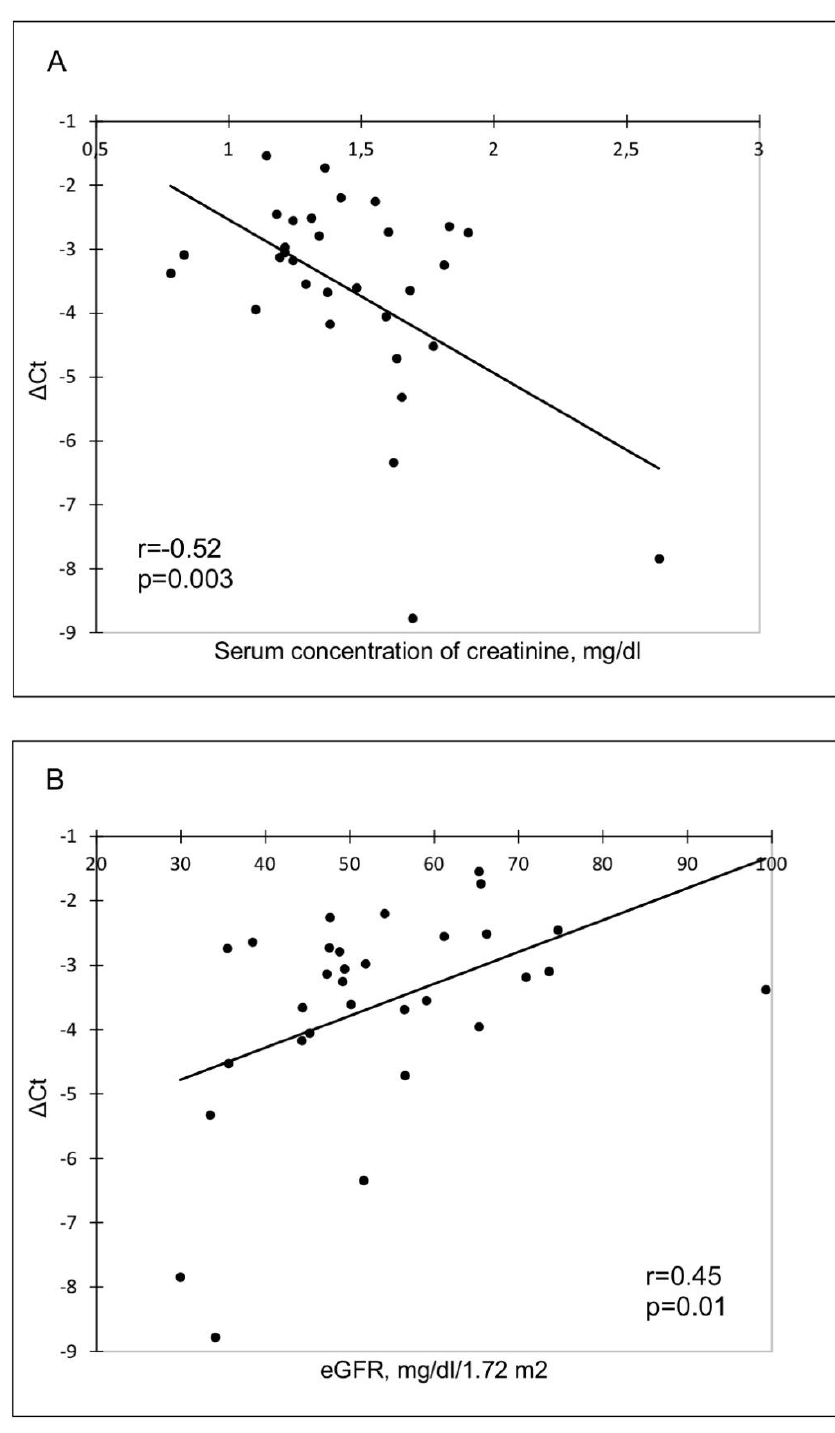
Figure 2. Correlation of miR-21 with ( A ) serum concentration of creatinine and ( B ) eGFR.